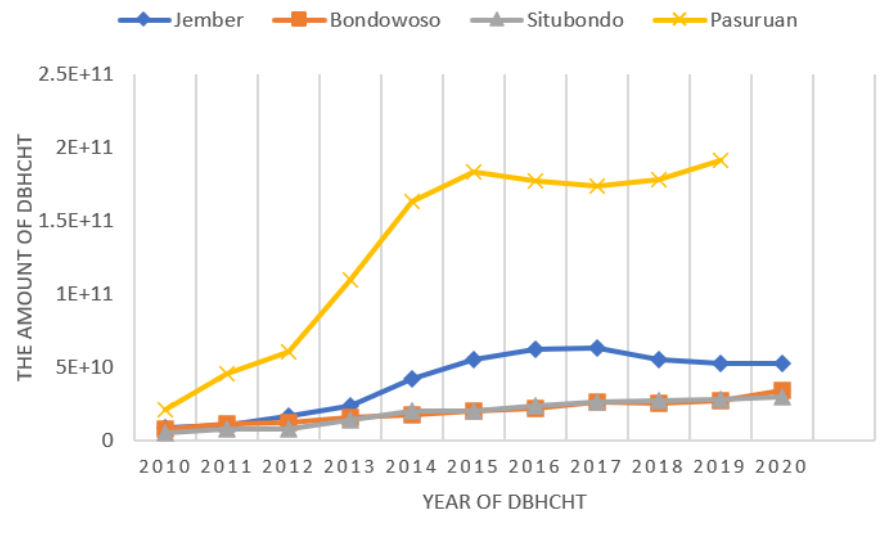
Figure 6. Comparing DBHCHT for